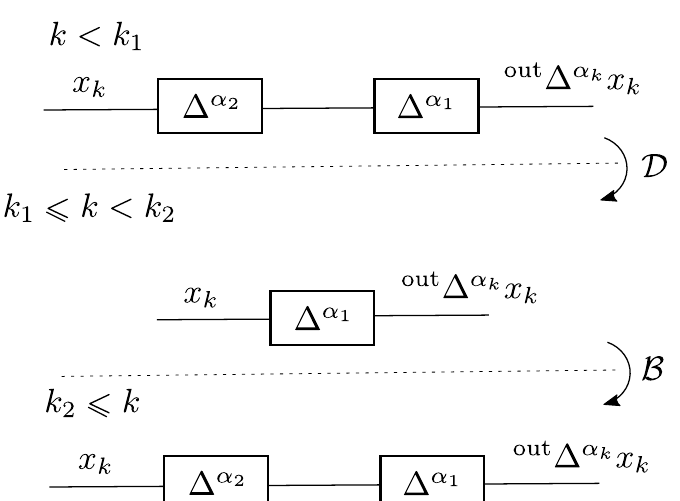
Figure A1. Conceptual analog model realization scheme of D -type difference